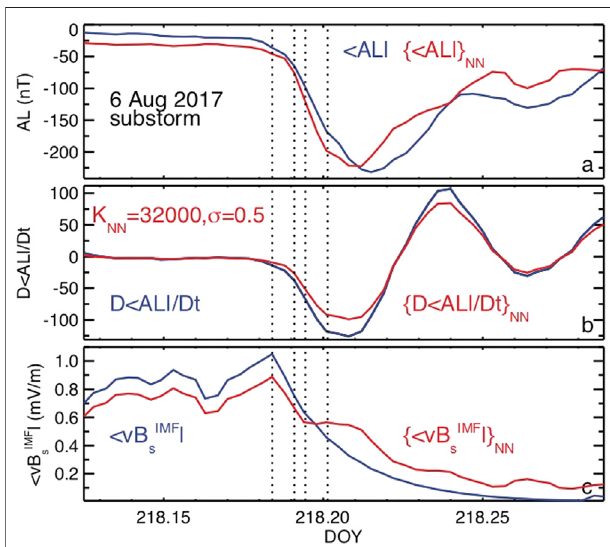
FIGURE 15 | The substorm part of the binning parameters (4) – (6) 〈 AL | , (cid:9)(cid:9)(cid:9)(cid:9)(cid:9) D 〈 AL | / Dt and 〈 vB IMF s (blue lines) and their means over 32 , 000 NN bins ( { ... } NN , red lines) for the 6 August 2017 substorm. Parameters 〈 AL | and D 〈 AL | / Dt are normalized bythecorrespondingunit convolution integrals 〈 1 | . Vertical dashed lines mark two dipolarization intervals considered in Section 4